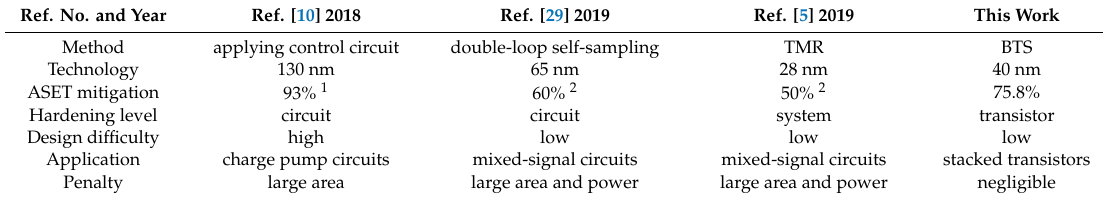
Table 2. Comparison with other state-of-the-art analog single-event transient (ASET) mitigation methods. Ref. No. and